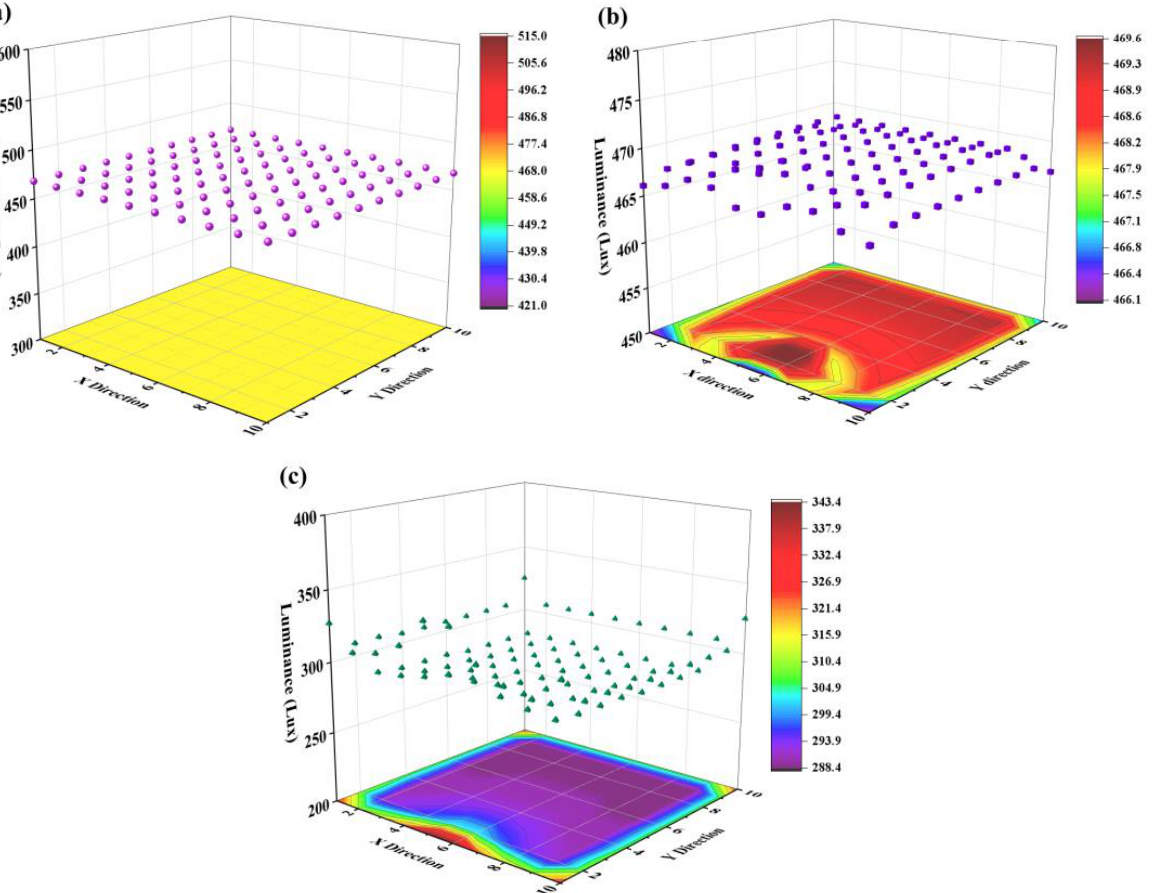
Figure 6. ( a ) Target spatial illuminance distribution ( E t ) of the WLED matrix. ( b ) Optimized spatial illuminance distribution ( E o ) of table tops under the WLED matrix. ( c ) Spatial illuminance distribution emitted by the WLED matrix ( E r ). The calculation results were obtained under the conditions that the dimension of the WLED matrix is 10 × 10, the error range ( δ ) is set as 2 lux, the illuminance of the window is 10,000 lux, the dimension of the window is 2.4 m 2 , and the distances between neighboring WLEDs are 2 m.